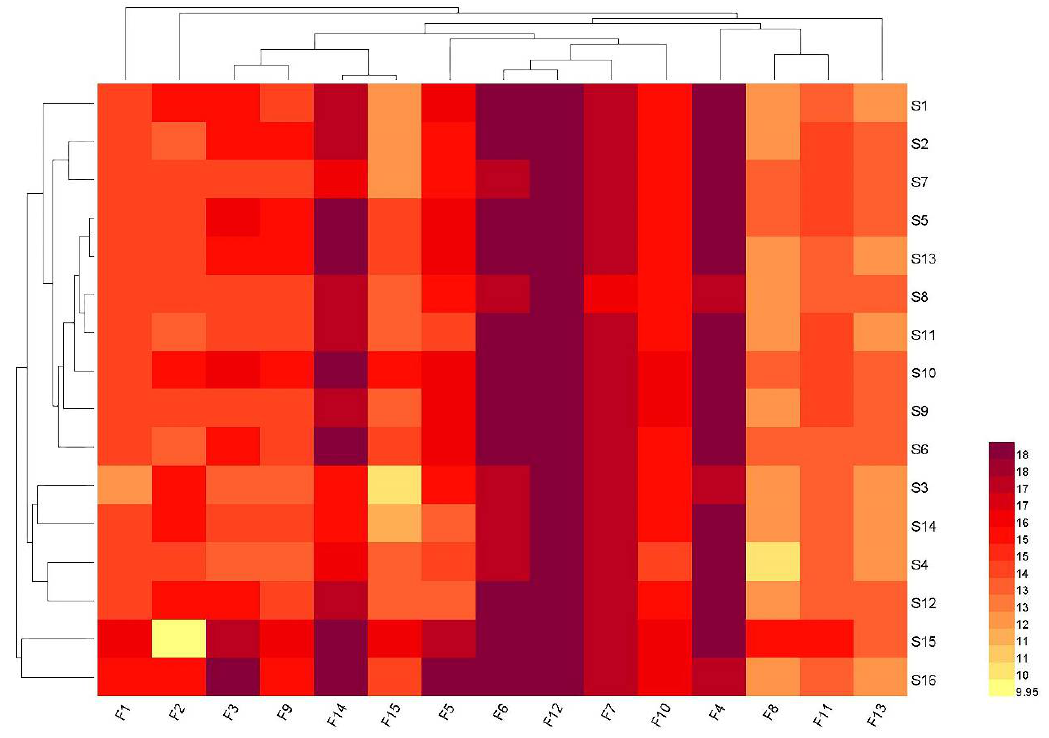
Figure 4. The heatmap HCA for 16 batches of PC.